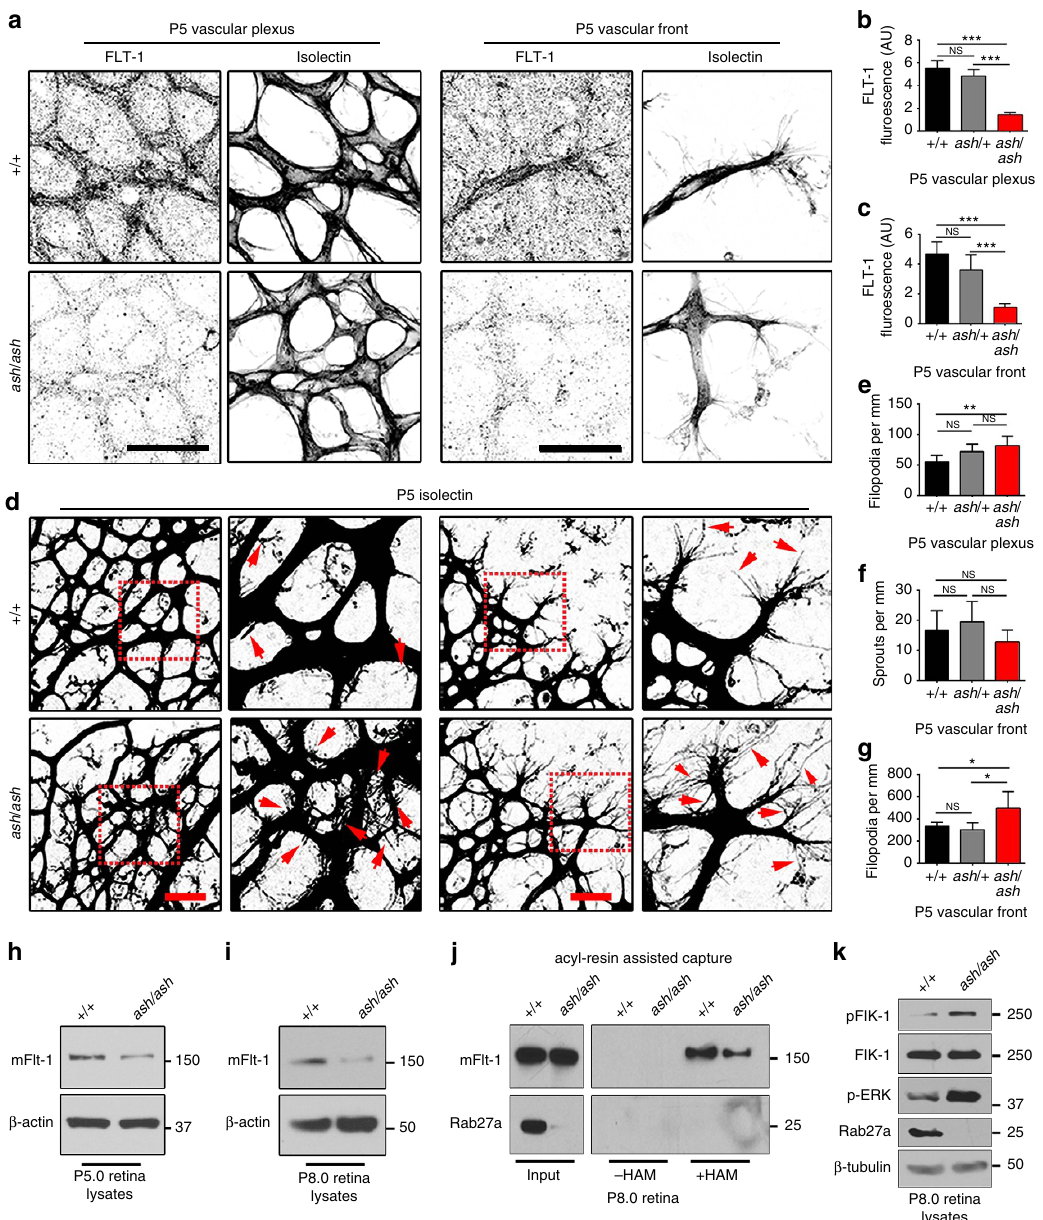
Figure 8 | Ashen retinal vessels have reduced FLT-1 and excess filopodia. ( a – c ) ( a ) FLT-1 immunofluorescence of retinas from P5 mice with indicated genotypes, scale bars: 50 m m. ( b , c ) Quantification of FLT-1 in indicated areas via integrated density. Scale bar, 25 m m. (No. of retinas: þ / þ , n ¼ 4; ash / þ , n ¼ 6; ash/ash, n ¼ 4). ( d – g ) ( d ) Immunofluorescence of retinas. Quantification of ( e ) filopodia in the plexus ( f ) sprouting, and ( g ) filopodia at the vascular front from P5 mice with indicated genotypes. Red box, magnified at right; arrows, filopodia. Scale bars: 25 m m. (No. of retinas from two independent litters: þ / þ , n ¼ 6, ash / þ n ¼ 5; ash/ash, n ¼ 7). ( h , i ) Immunoblot for mFLT-1 in retinal lysates from indicated genotypes at P5 ( h ) and P8 ( i ); four replicates per stage. ( j ) Acyl-RAC and immunoblot for mFLT-1 and Rab27a from retinal lysates at indicated stages; three replicates. ( k ) Immunoblot of retinal lysates as indicated; three replicates. Statistics: Shown are means þ 95% CI. One-way ANOVA and pairwise comparison with post-hoc Tukey’s range test. * P r 0.05; ** P r 0.01; *** P r 0.001; NS, not significant. the vascular plexus behind the front in wild-type controls ( þ / þ ) vascular morphology showed significantly increased filopodia in at post-natal day 6.5 (P6.5) that were dramatically reduced in the plexus vessels and at the vascular front of ash/ash retinas ash/ash homozygous littermates, along with undetectable levels of at P5, although overall sprout numbers were not affected Rab27a in ash/ash retinal lysates (P6.0) (Supplementary Fig. 8a,b). (Fig. 8d–g, inlay, red arrows). We also analysed later stages Consistent with the hypothesis that loss of Rab27a destabilizes (Supplementary Fig. 8c–h) and found that the increased filopodia VEGFR1 in vivo , post-natal (P5) retinal vessels of ash/ash numbers were resolved at the vascular front by P6.5, but persisted homozygous mice had significantly reduced levels of FLT-1 in the plexus vessels through P8.5. Consistent with these findings, staining at the vascular front and in the plexus behind the filopodia length was also increased in P8.5 retinas in the vascular front compared to littermate controls (Fig. 8a–c). Examination of plexus but not at the vascular front (Supplementary Fig. 9a–c), NATURE COMMUNICATIONS|8:15699|DOI: